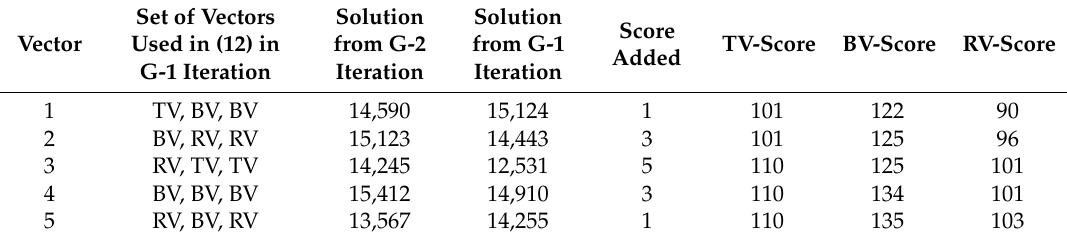
Table 8. Results of an updated score of a set of vectors in iteration G. TV, target vectors. BV, best vectors. RV, random